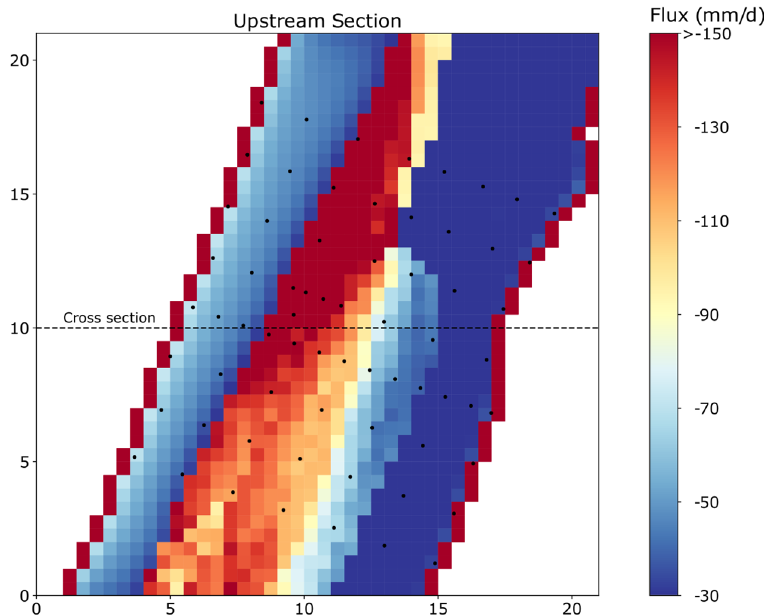
Figure 9. Map of the river–aquifer exchange fluxes simulated with the groundwater model for the upstream section. Black dots indicated measurement points vertical temperature profiles. The Black dotted line indicates the location of the cross section through the river (Figure 10).